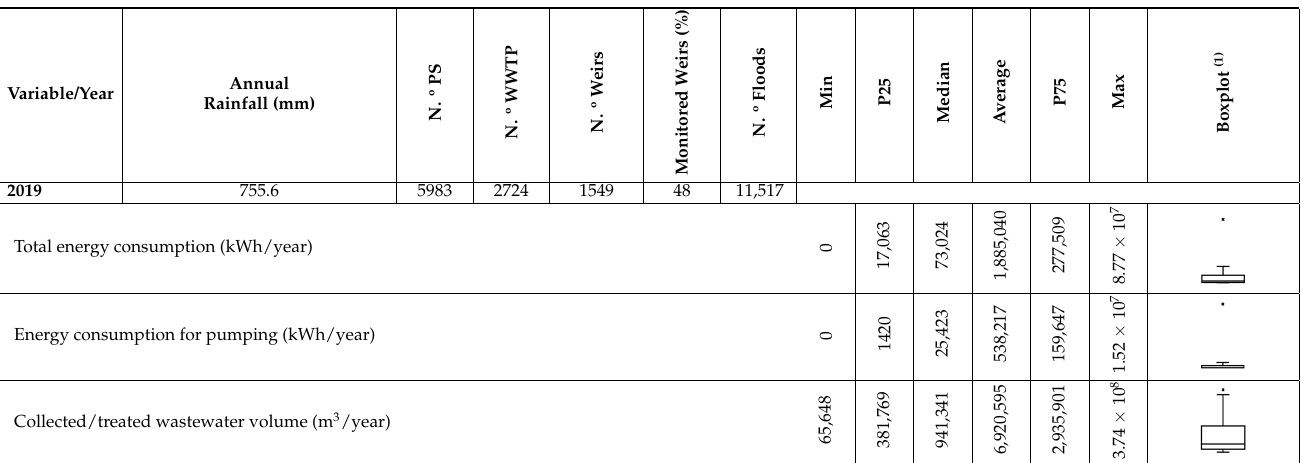
Table A6. National characterization for the evaluation of the W ‐ E ‐ G nexus for